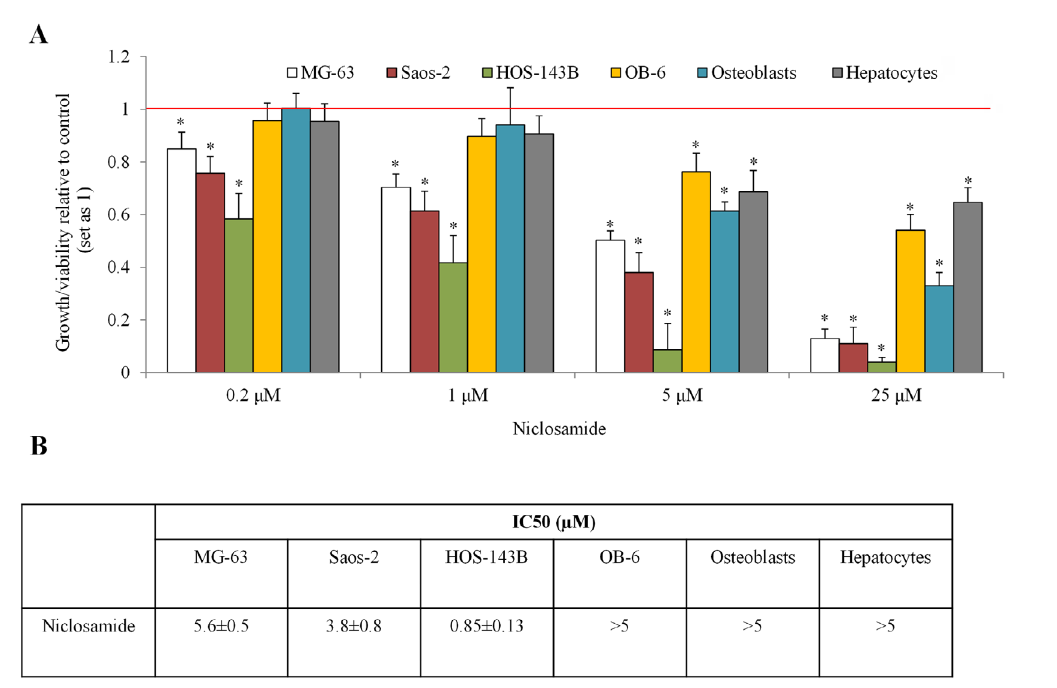
Figure 1 – Niclosamide is preferentially active against osteosarcoma cells. (A) Niclosamide at 0.2, 1, 5 and 25 µM dose-dependently decrease growth/ viability of multiple osteosarcoma cell lines: MG-63, Saos-2 and HOS-143B. Niclosamide at 5 and 25 µM but not 0.2 and 1 µM significantly decrease growth/viability of OB-6, osteoblastic and hepatocyte cells. After 3 days treatment, cell growth/viability was measured using CellTiter® 96 Aqueous One Solution cell proliferation assay. *, p<0.5, compared to control. Control was set up as 1. Unpaired Student’s t test was conducted. (B) IC was determined using GraphPad Prism software. on different types of cells. IC 50